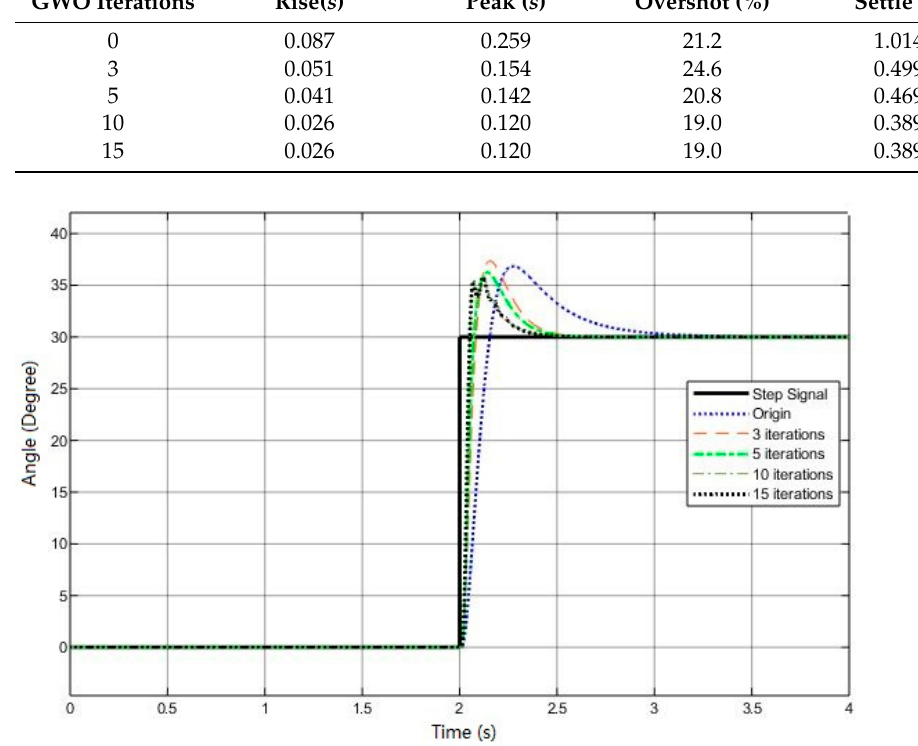
Figure 5. Comparison of the roll sub ‐ controllers optimised by GWO in simulation.